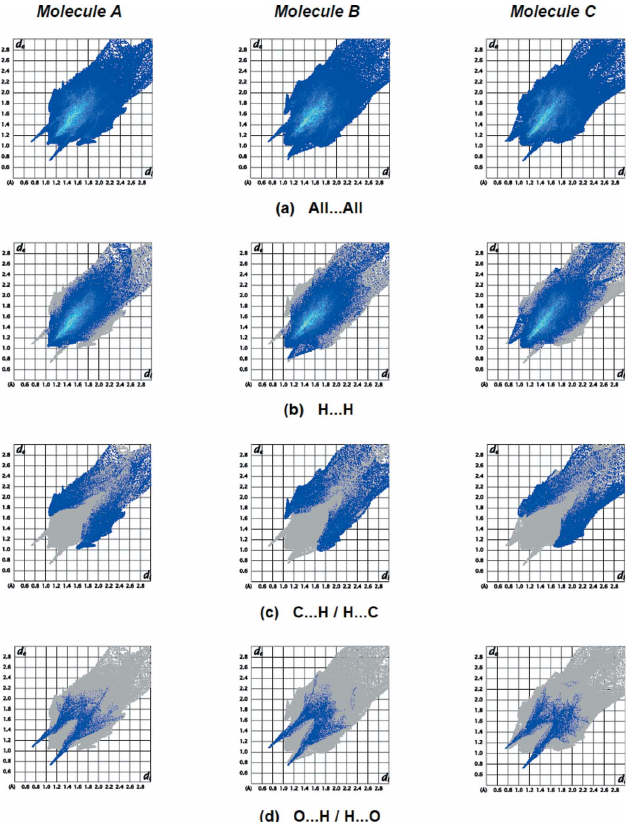
Figure 5 ( a ) View of the three-dimensional Hirshfeld surface for molecule A ; ( b ) view of the three-dimensional Hirshfeld surface for molecule B ; ( c ) view of the three-dimensional Hirshfeld surface for molecule C . Some intermolecular N—H (cid:2)(cid:2)(cid:2) O and C—H (cid:2)(cid:2)(cid:2) O interactions are shown as dashed lines.